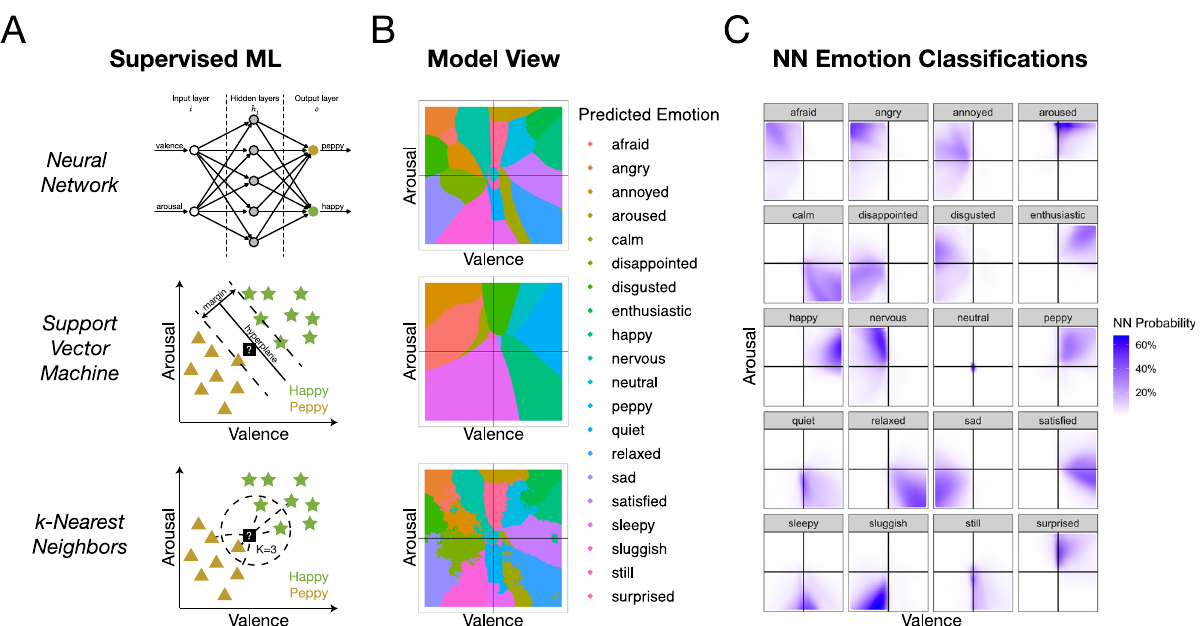
Fig. 2 Machine learning approaches. A Supervised machine learning. Three supervised machine learning algorithms were used to train a classi fi er on all 20 emotions from the emotion classi fi cation data. Simpli fi ed schematics for each approach are shown demonstrating how the model classi fi es toy data as either “ happy ” or “ peppy ” . Model-speci fi c parameters were optimized using tenfold cross-validation on the training dataset. B Model view. Graphs show most likely emotion class for each valence-arousal location which visualizes one model ’ s view of the emotion space. C Neural network emotion classi fi cations. Visualizes the probability of each emotion label classi fi cation for the emotion space, with darker colors indicating higher